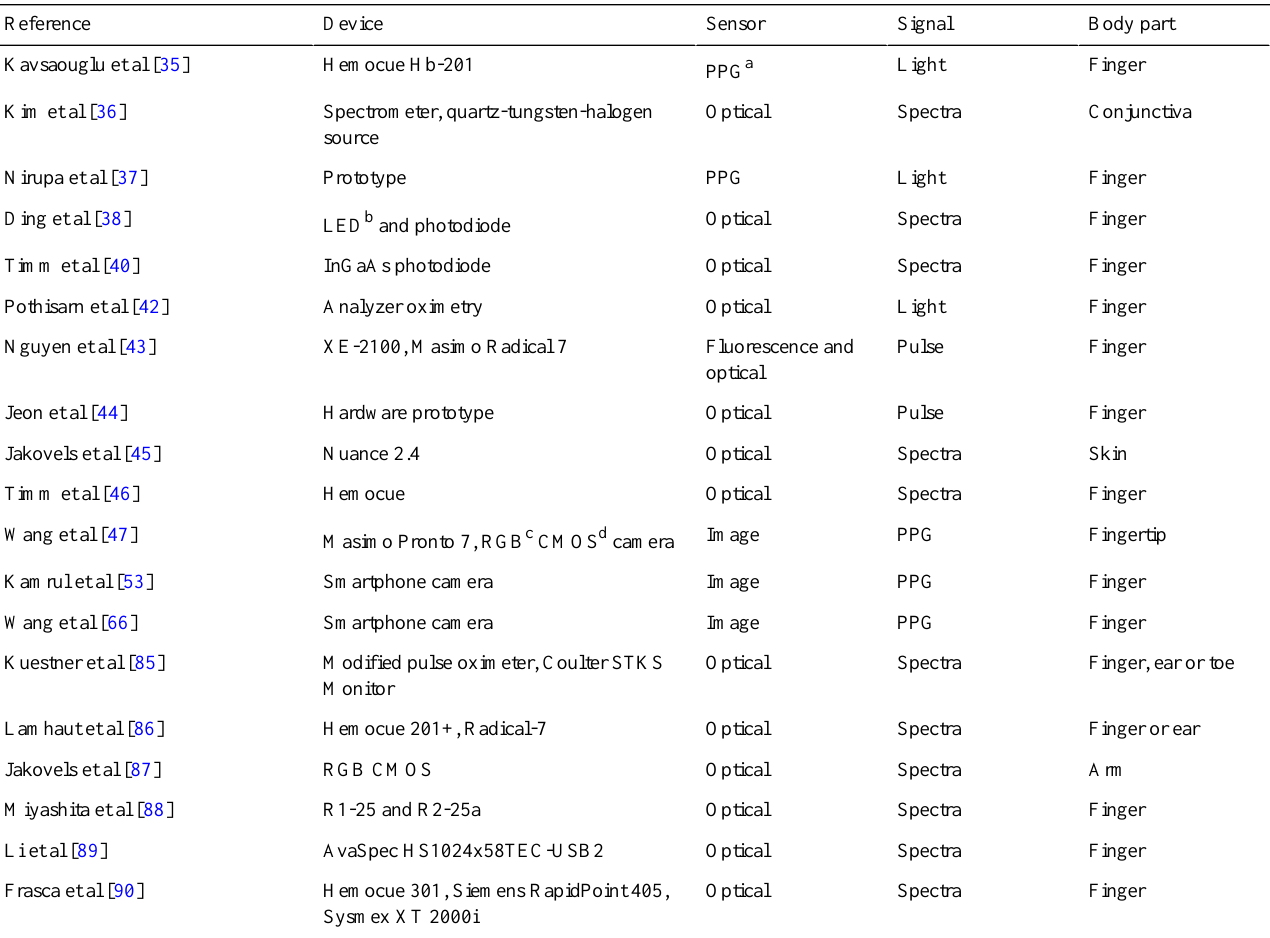
Table 2. Summary of different sensors, signal types, and body sites used for hemoglobin level measurement.